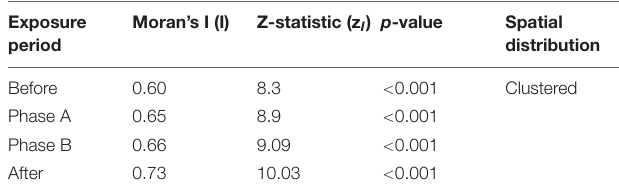
TABLE 3 | Moran’s I analysis results by analysis period for the PMRF exemplar, including Moran’s I value (I), the z-statistic (z I ), and the associated p